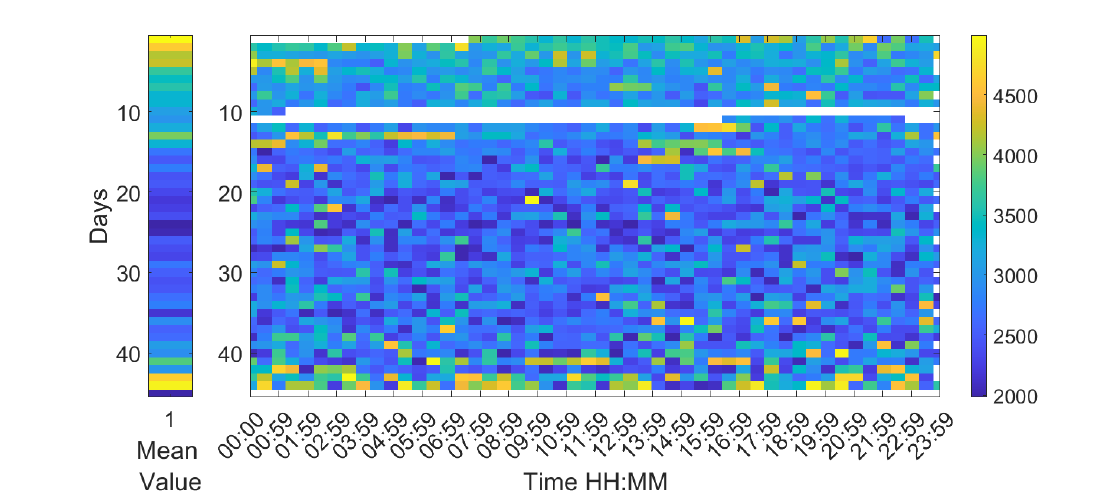
Figure 7. Map of the maximum frequency at 30 min intervals during the 44 days of a complete production cycle. The horizontal axis shows the hours of the day and night, and the vertical axis shows the days of the